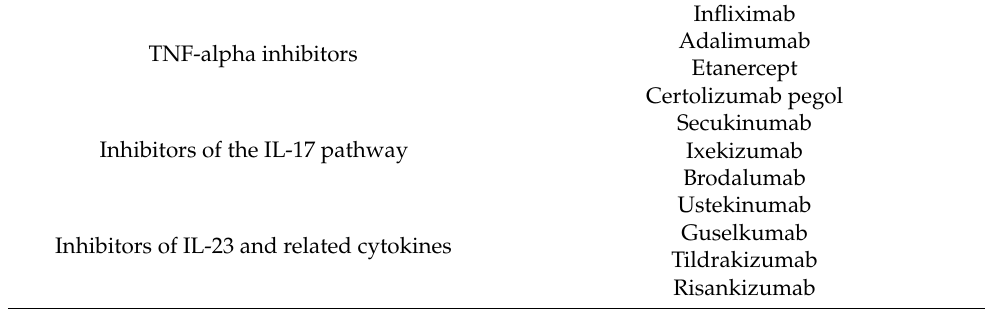
Table 1. Currently available biologic agents as revolutionary therapeutic tools in the management of moderate-to-severe psoriasis in